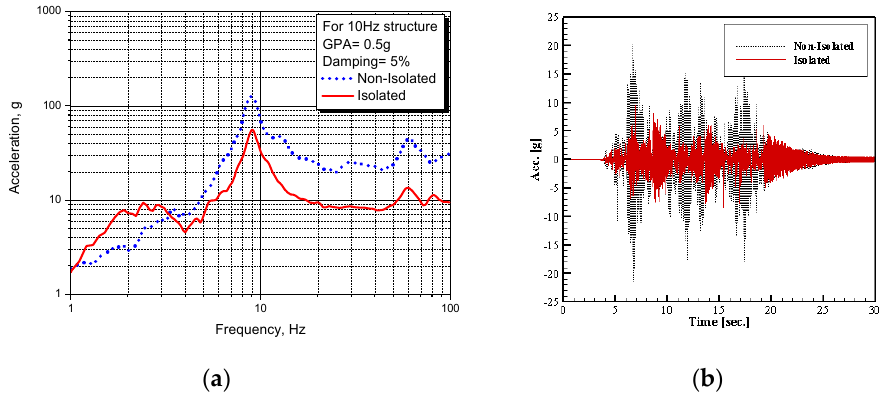
Figure 14. Effect of isolation in the acceleration response of 10 Hz beam as a secondary structure (BDBE: 0.5 g): ( a ) response spectra; ( b ) time history.